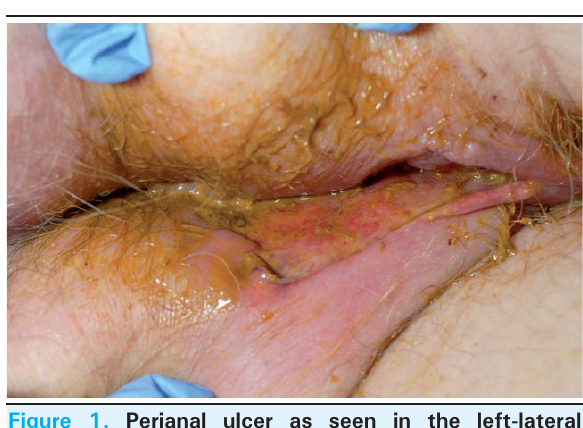
Figure 1. Perianal ulcer as seen in the left-lateral position